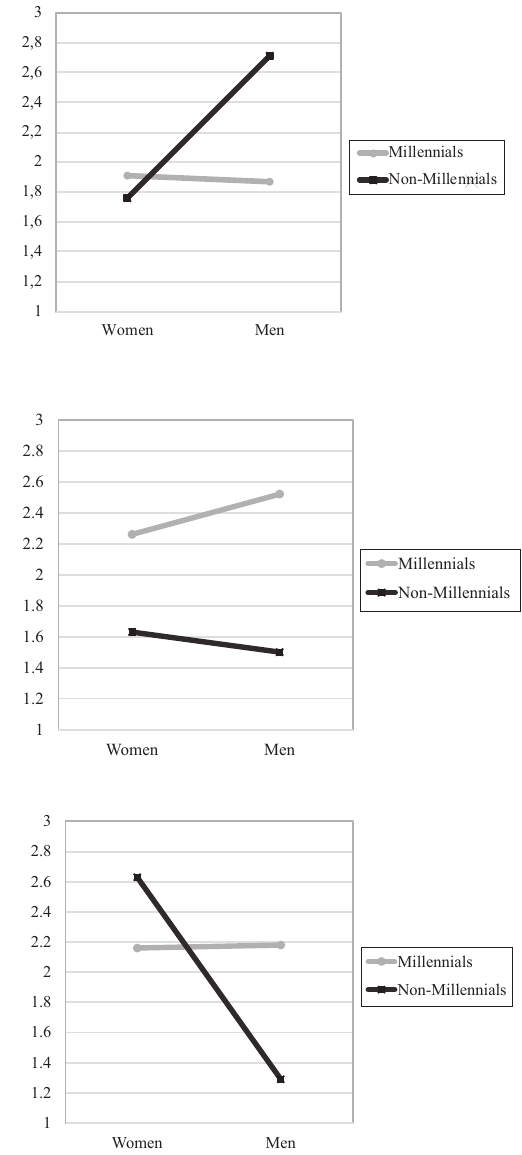
Figure 3. Triple moderation effect of age and gender on loyalty in Instagram Stories